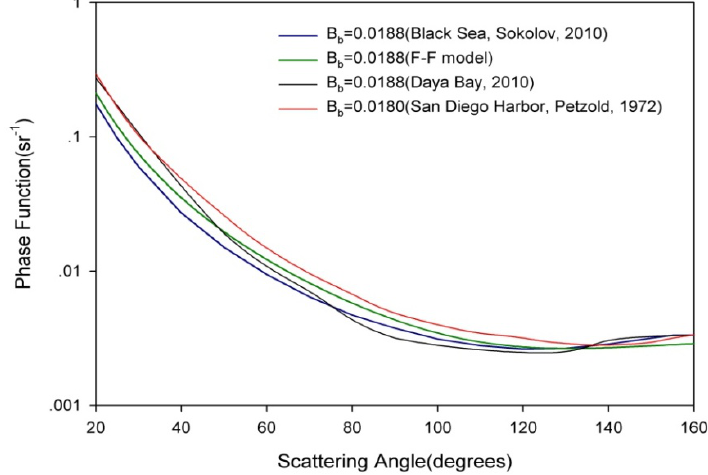
Figure 13. Comparison of Daya Bay 2010 phase function with phase function derived from Petzold measurements in San Diego Harbor [23], Sokolov measurements in Black Sea [4], and the Fournier-Forand (F-F) analytical phase functions. B functions are about